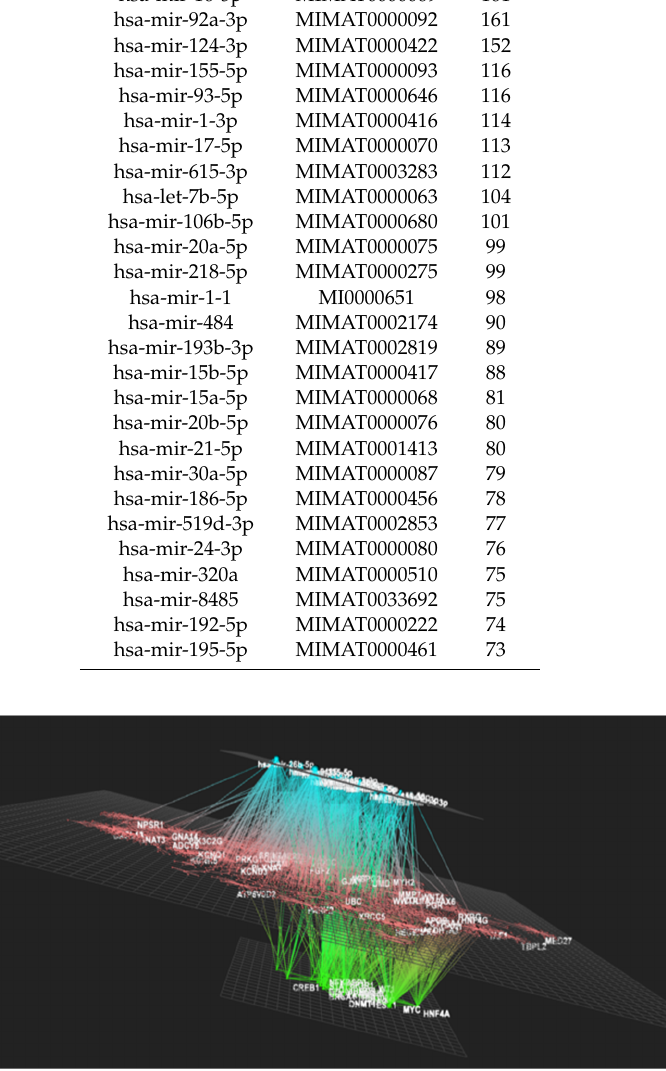
Figure 7. Bioinformatics analyses of potential miRNA involved in the mediation of the Passiflora setacea juice’s nutrigenomic effect observed. OmicsNet online tool was used to identify interactions between the differentially expressed genes identified (in pink) with the potential transcription factors identified (in green), and potential miRNAs involved (in blue).